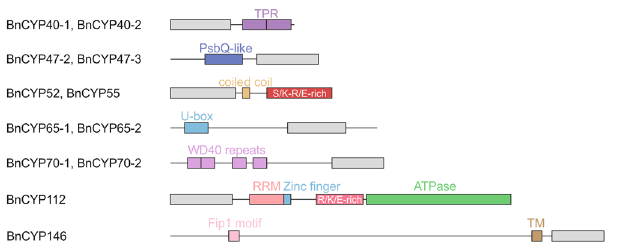
Figure 2. Domain structure of multi-domain B. napus cyclophilins. While most of the CYPs are single- domain proteins, 12 BnCYPs possess additional domains for specific tasks. CLDs are represented by a grey box. RRM = RNA recognition motif, TPR = tetratricopeptide repeat, TM = transmembrane domain.